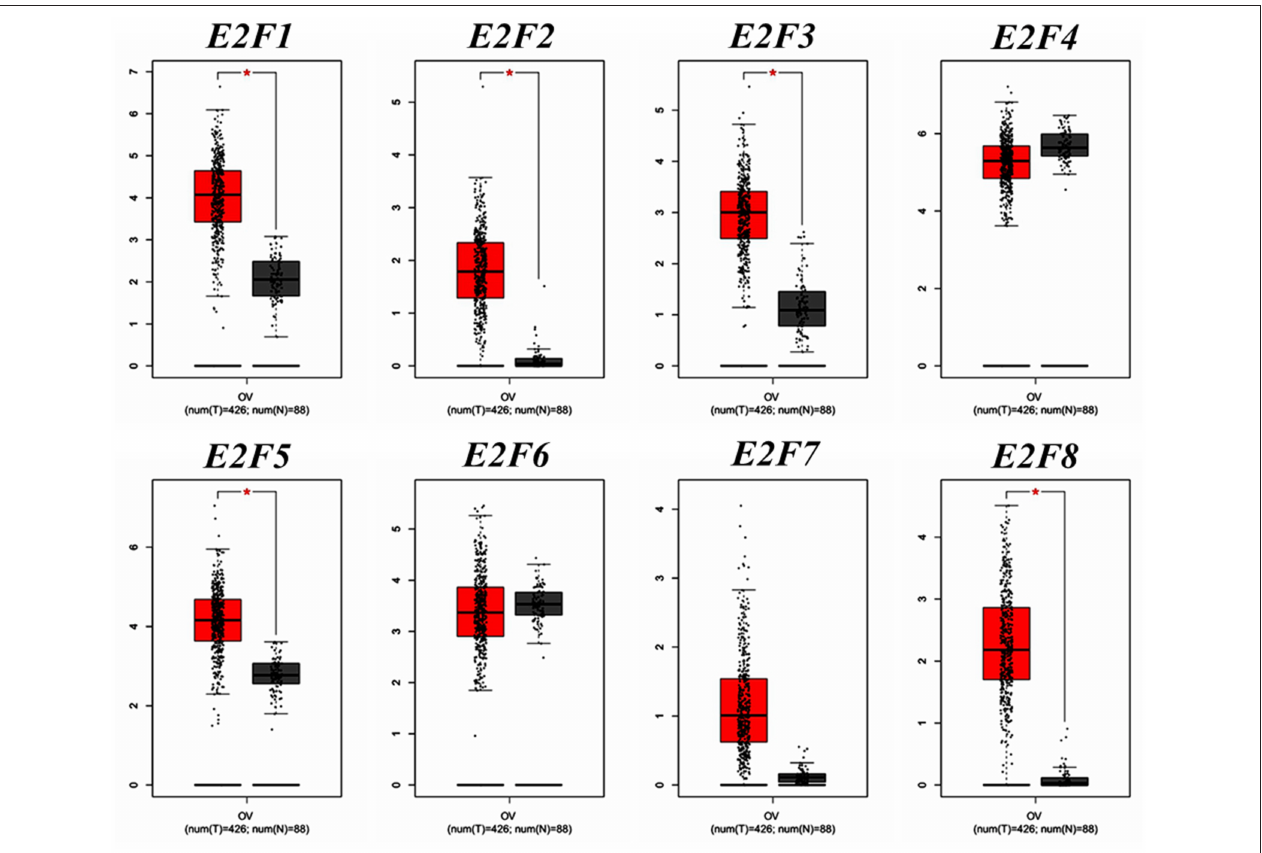
FIGURE 2 | The expression of E2F family members in OC patients (GEPIA). Box plots derived from gene expression data for GEPIA comparing the expression of a specific E2F family member in OC tissue and normal tissues; the p -value was set at 0.05. The mRNA expression pattern of E2F1 , E2F2 , E2F3 , E2F4 , E2F5 , E2F6 , E2F7 , and E2F8 between OC and normal tissues. *Indicate that the results are statistically